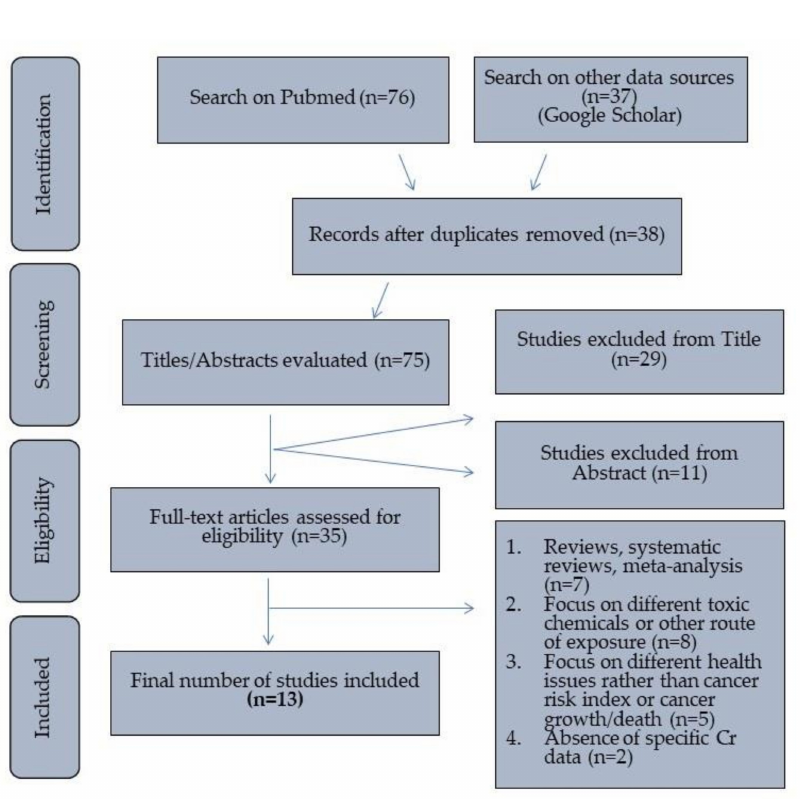
Figure 1. Flow chart of the identification and selection of eligible epidemiological studies investigating the relationship between chromium exposure and carcinogenic